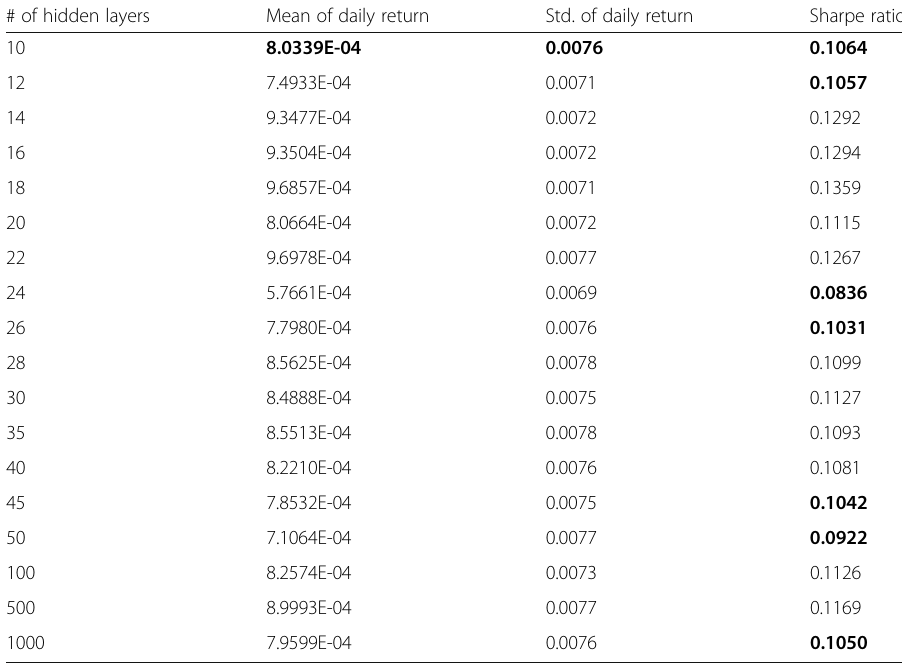
Table 8 Simulation results with ANN/DNN classifiers using transformed data with PCs = 31 # of hidden layers Mean of daily return Std. of daily return